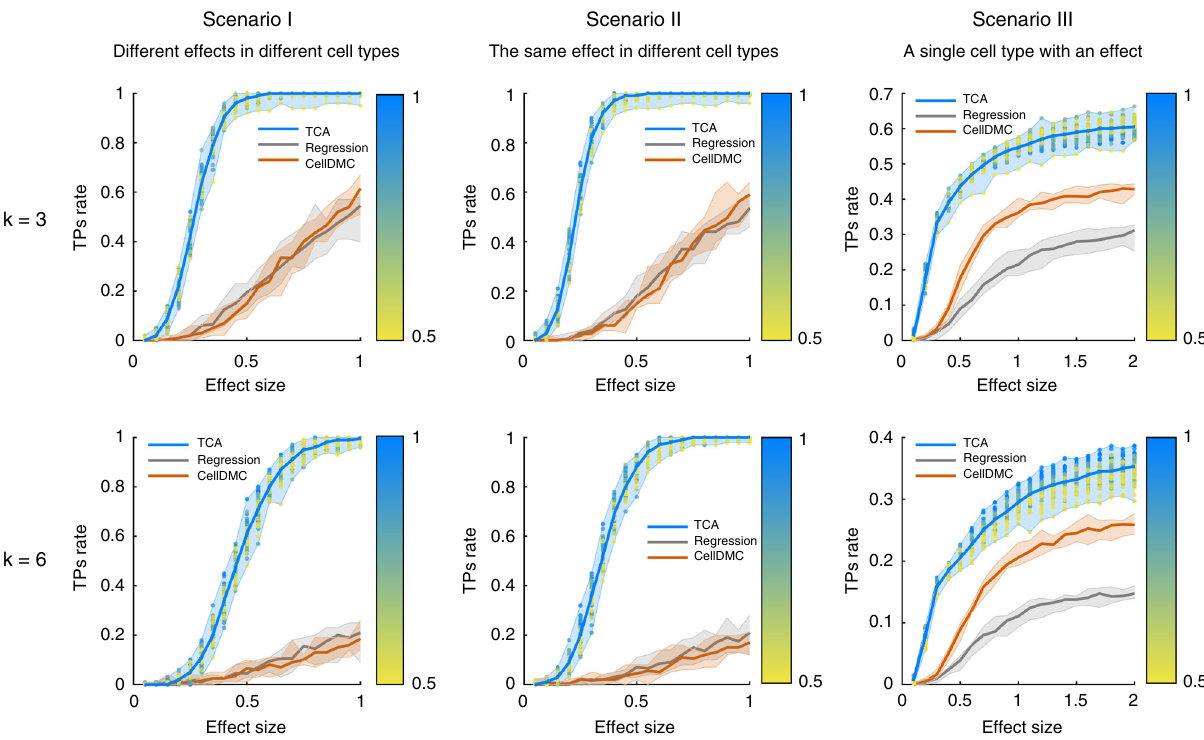
Fig. 3 An evaluation of power for detecting cell-type-speci fi c associations with DNA methylation. Performance was evaluated using three approaches: TCA, a standard linear regression with the observed bulk data, and CellDMC with the true cell-type proportions as an input. The numbers of true positives (TPs) were measured under three scenarios using a range of effect sizes: different effect sizes for different cell types (Scenario I), the same effect size for all cell types (Scenario II), and a single effect size for a single cell type (Scenario III); each of the scenarios was evaluated under the assumption of three constituting cell types ( k = 3; top row) and six constituting cell types ( k = 6; bottom row). Lines represent the median performance across 10 simulations and the colored areas re fl ect the results range across the multiple executions. The colored dots re fl ect the results of TCA under different initializations of the cell-type proportion estimates (i.e., different levels of noise injected into TCA), where the color gradients represent the mean absolute correlation of the initial estimates with the true values (across all cell